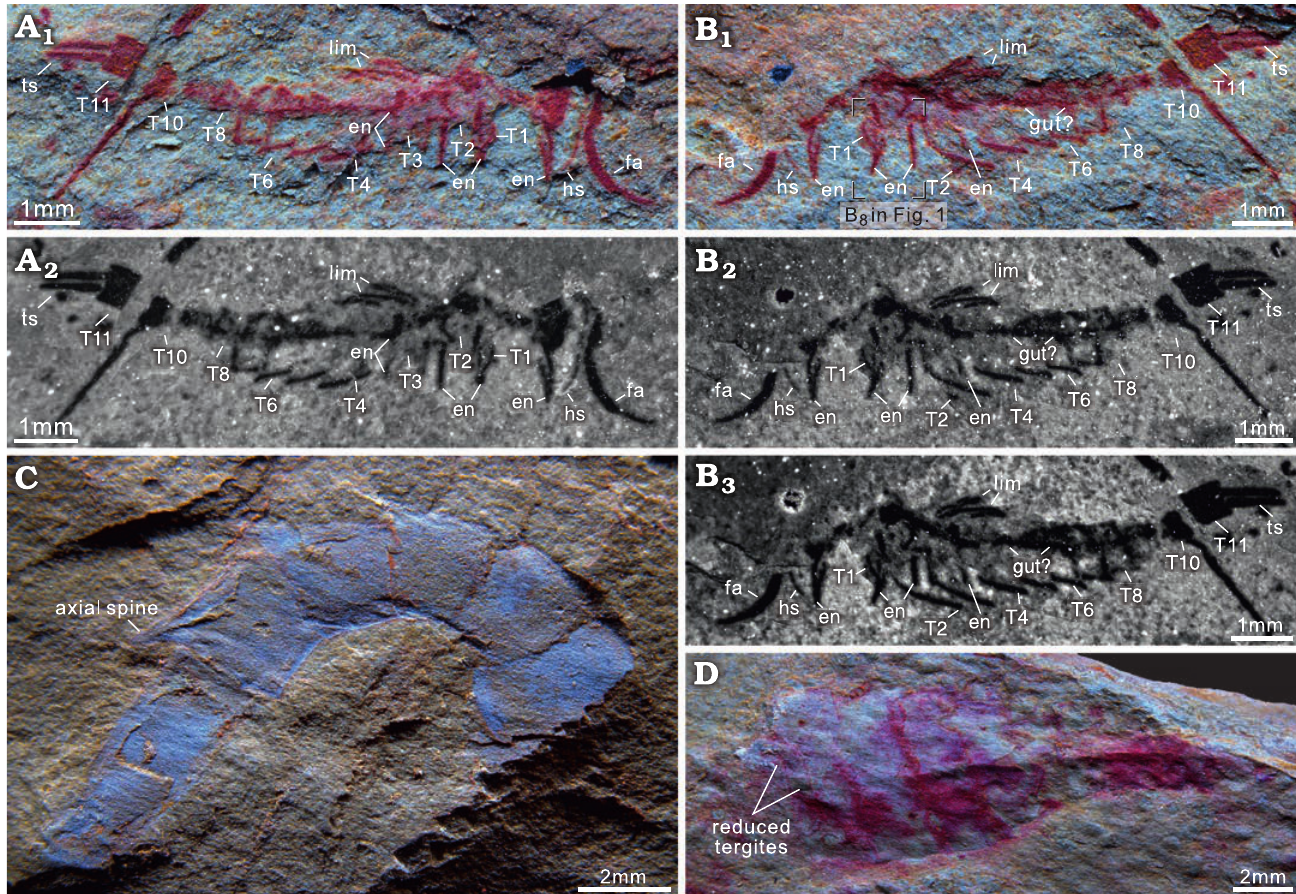
Fig. 2. Euarthropods Astutuscaris bispinifer gen. et sp. nov. (A, B) and Guangweicaris spinatus Luo, Fu, and Hu, 2007 (C, D) collected from Cambrian Guanshan Biota, Lihuazhuang village, Yunnan, China. A . RCP 0002a, specimen before preparation. B . RCP 0002b, specimen before preparation (B 1 , B 2 ) and after preparation (B 3 ). C . RCP 0003, a small and incomplete specimen about 16 mm in length. D . RCP 0004, a small specimen about 17 mm in length. Natural light photographs (A 1 , B 1 , C, D); fluorescent photographs (A 2 , B 2 , B 3 ,). Abbreviations: en, endopod; ex, exopod; ey, eye; fa, frontal